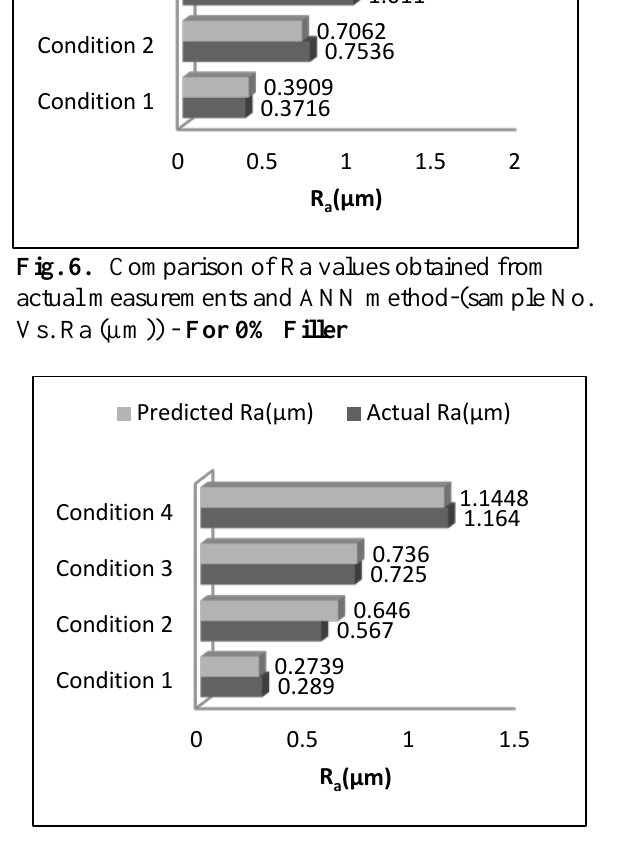
Fig. 9. Comparison of Ra values obtained from actual measurements and ANN method-(sample No. Vs. Ra (µm)) - For 15%